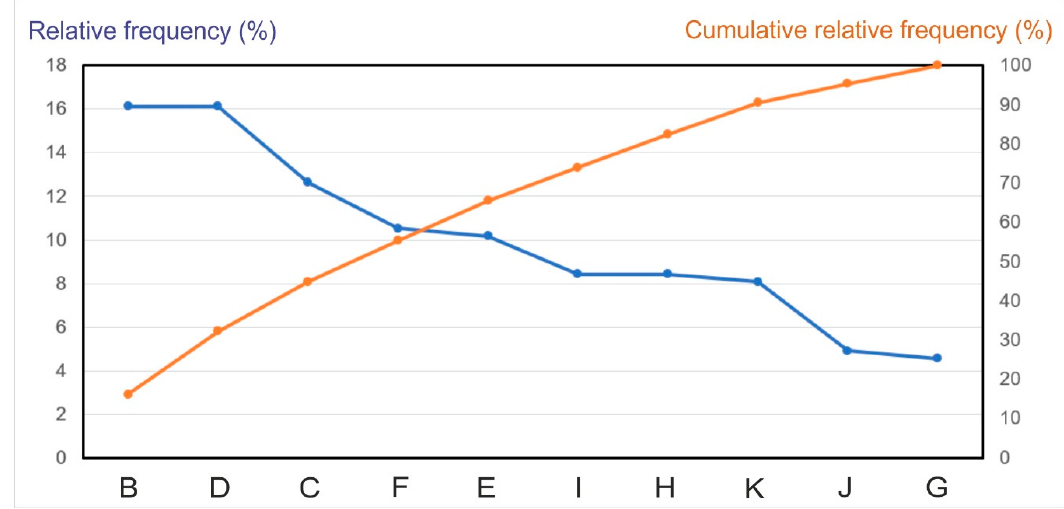
Figure 5. Relative frequency and cumulative relative frequency of PS-OSs characteristics described in papers of our paper database—results of the second assignment process (paper groups are marked with the same letters as the paper groups listed above, see Table 1.).